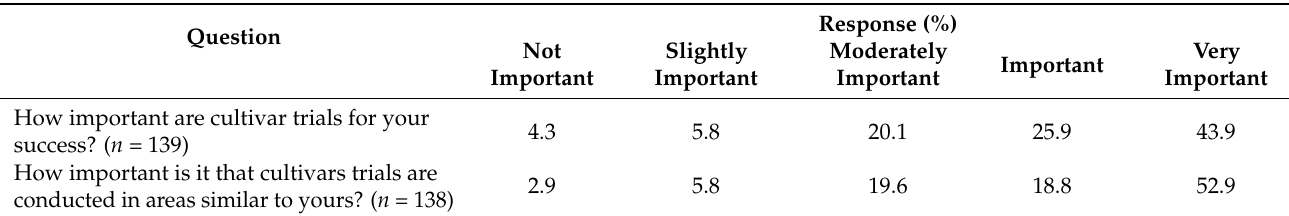
Table 3. Responses of commercial farmers at the 2019 Mid-Atlantic Fruit and Vegetable Convention in Hershey, PA, USA to questions about cultivar